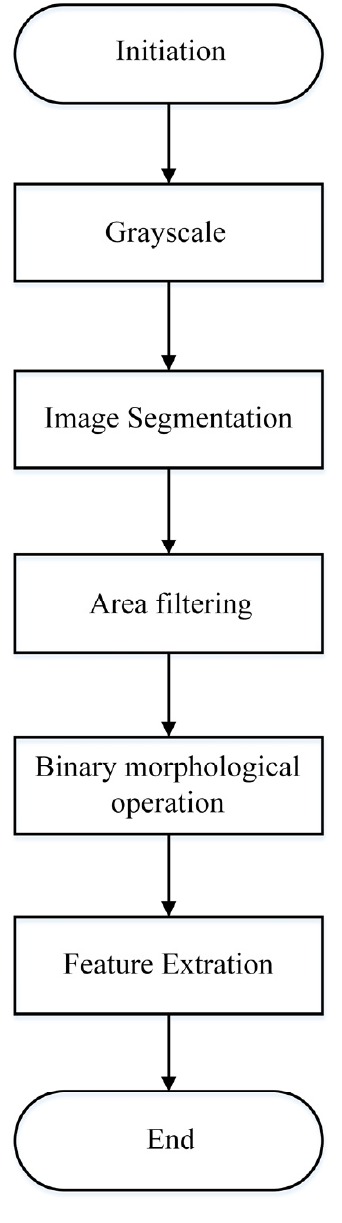
Figure 3. Image processing and analysis block diagram.